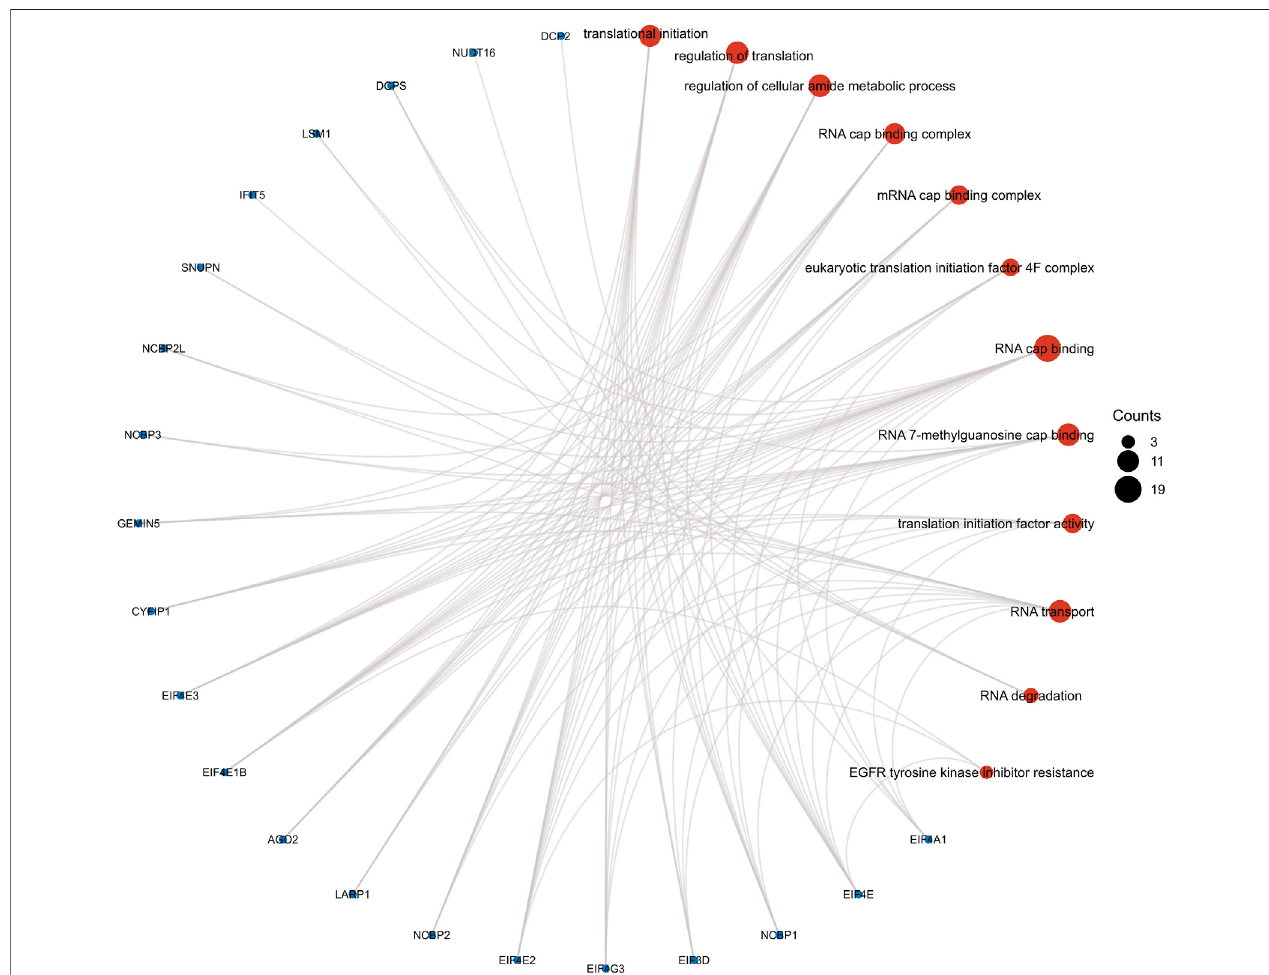
FIGURE 5 | Results from gene ontology functional and Kyoto Encyclopedia of Genes and Genomes pathway enrichment analyses for the identi fi ed differentially expressed genes.